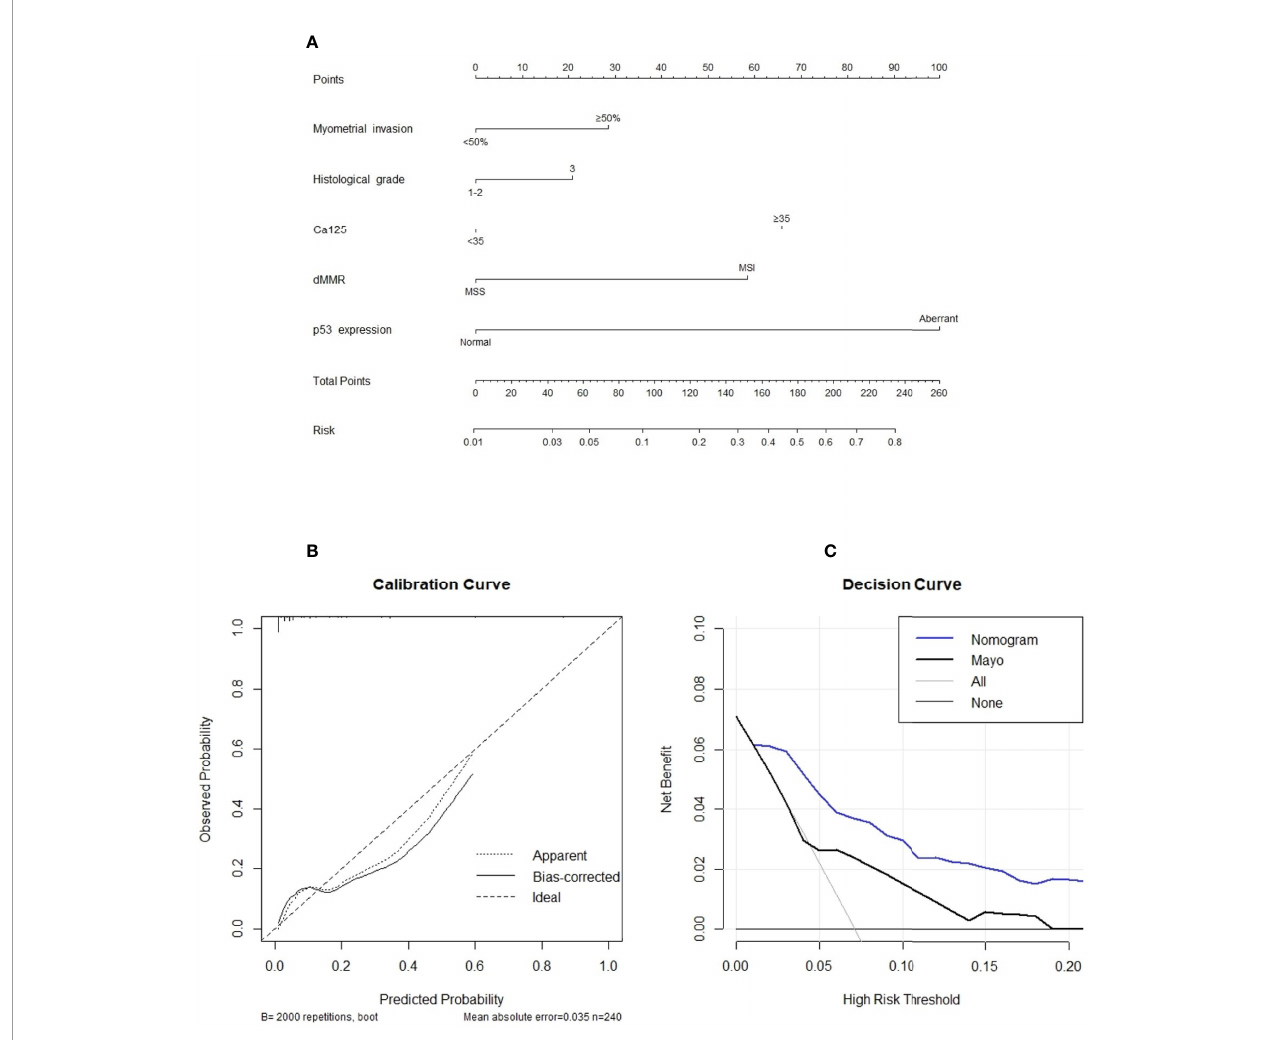
FIGURE 1 | (A) A nomogram for predicting the likelihood of positive lymph node status. To use the nomogram, the value for each predictor is determined by fi rst drawing a line upward to the point reference line. The points are then summed and a line is drawn downward from the total points line to determine the predicted probability of node positivity. (B) Calibration plot of the observed proportions and predicted probabilities of lymph node metastasis based on the novel nomogram. The predicted probability of pathological lymph node invasion aligns closely with the actual probability. (C) , decision curve analyses demonstrating the net bene fi t associated with the use of the novel nomogram for the detection of lymph node